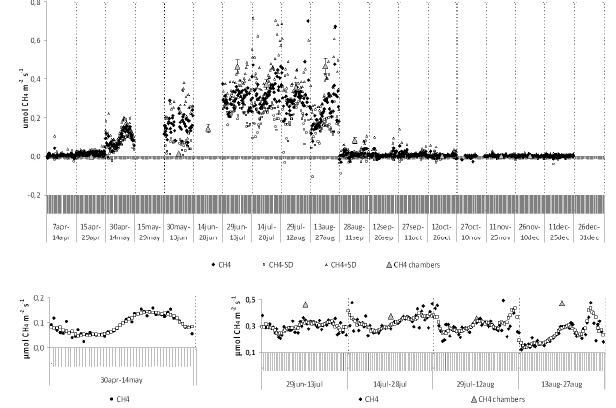
Fig. 5. Average daily variation during 2 weeks periods (with detail of CH 4 fluxes in periods with higher emissions). Data are binned by time of day and then averaged for 2 weeks periods. The stan- dard deviations are calculated on data passing the quality test on turbulence